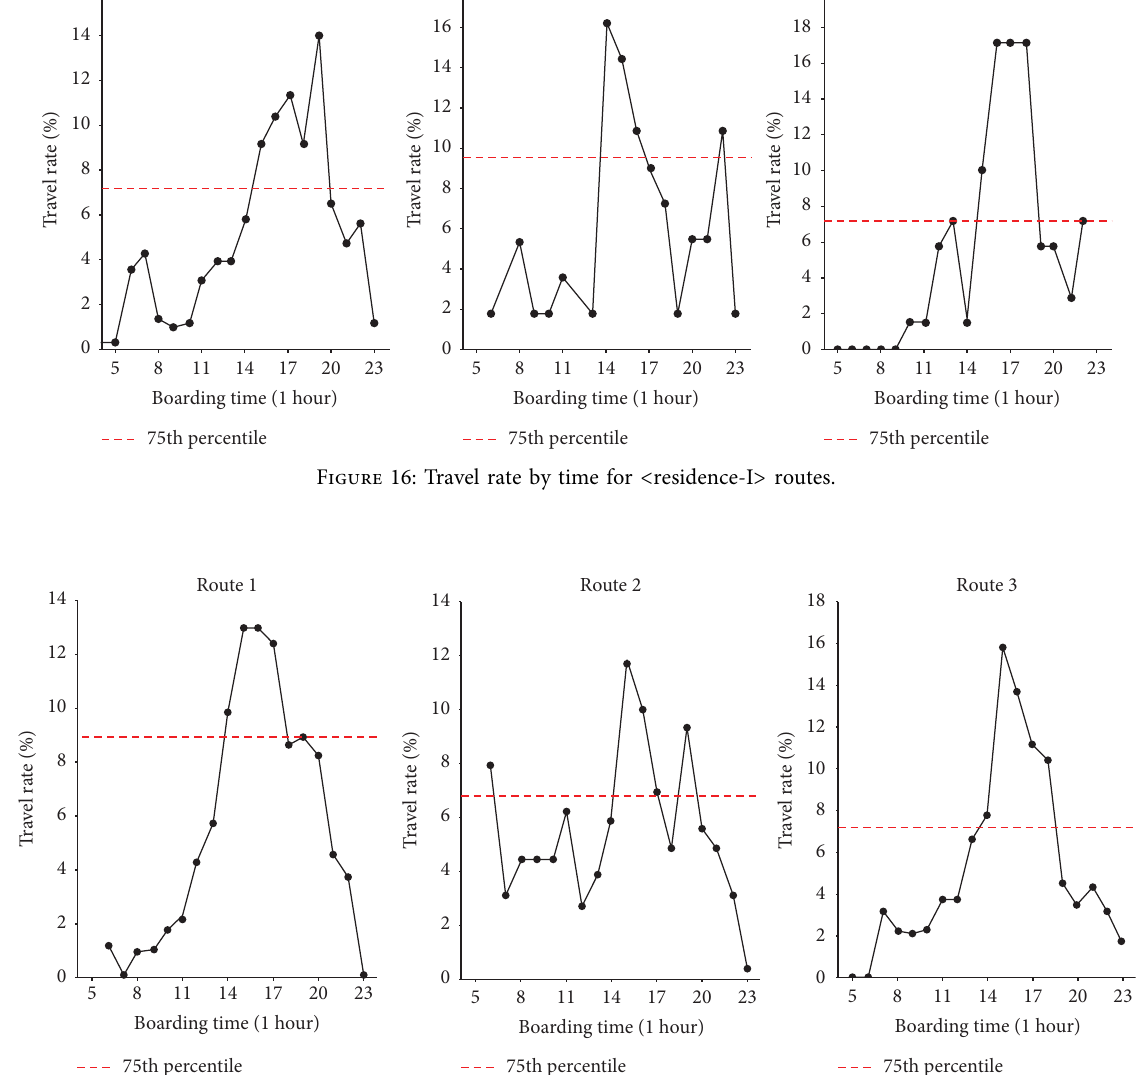
Figure 17: Travel rate by time for < residence-II >